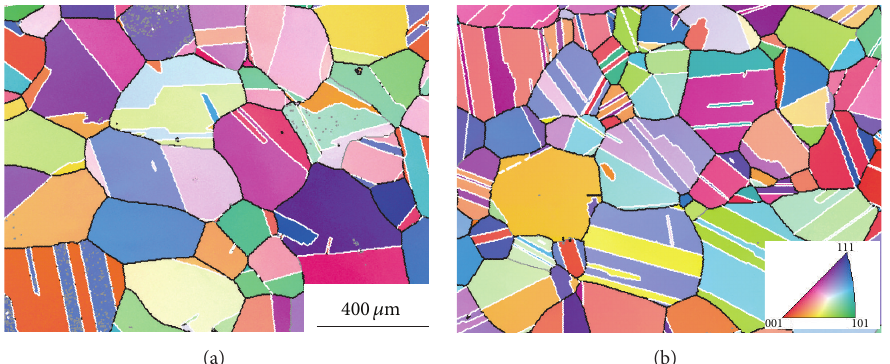
Figure 9: Microstructure of 316LN steels with different N contents heat treated at 1473 K for 60 min: (a) 08N; (b)